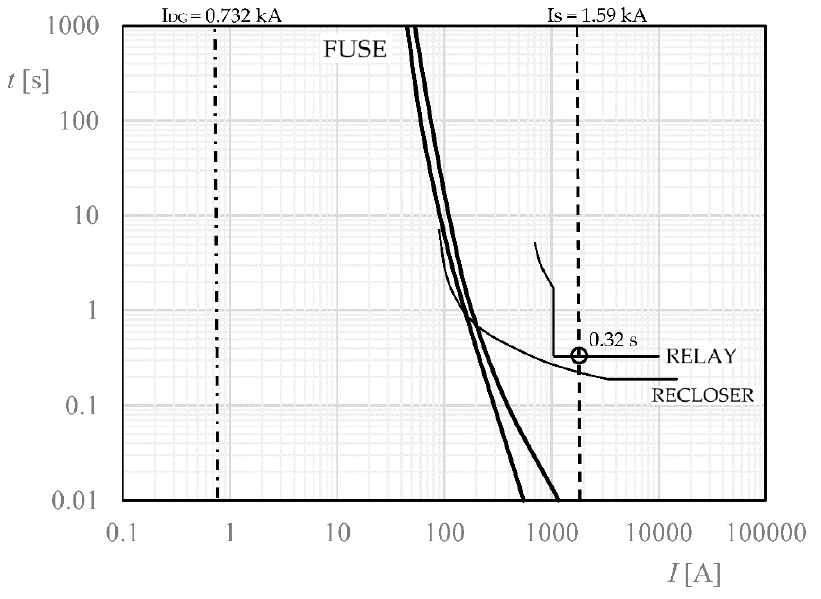
Figure 2. Short circuit upstream of DG. See also Figure 1.